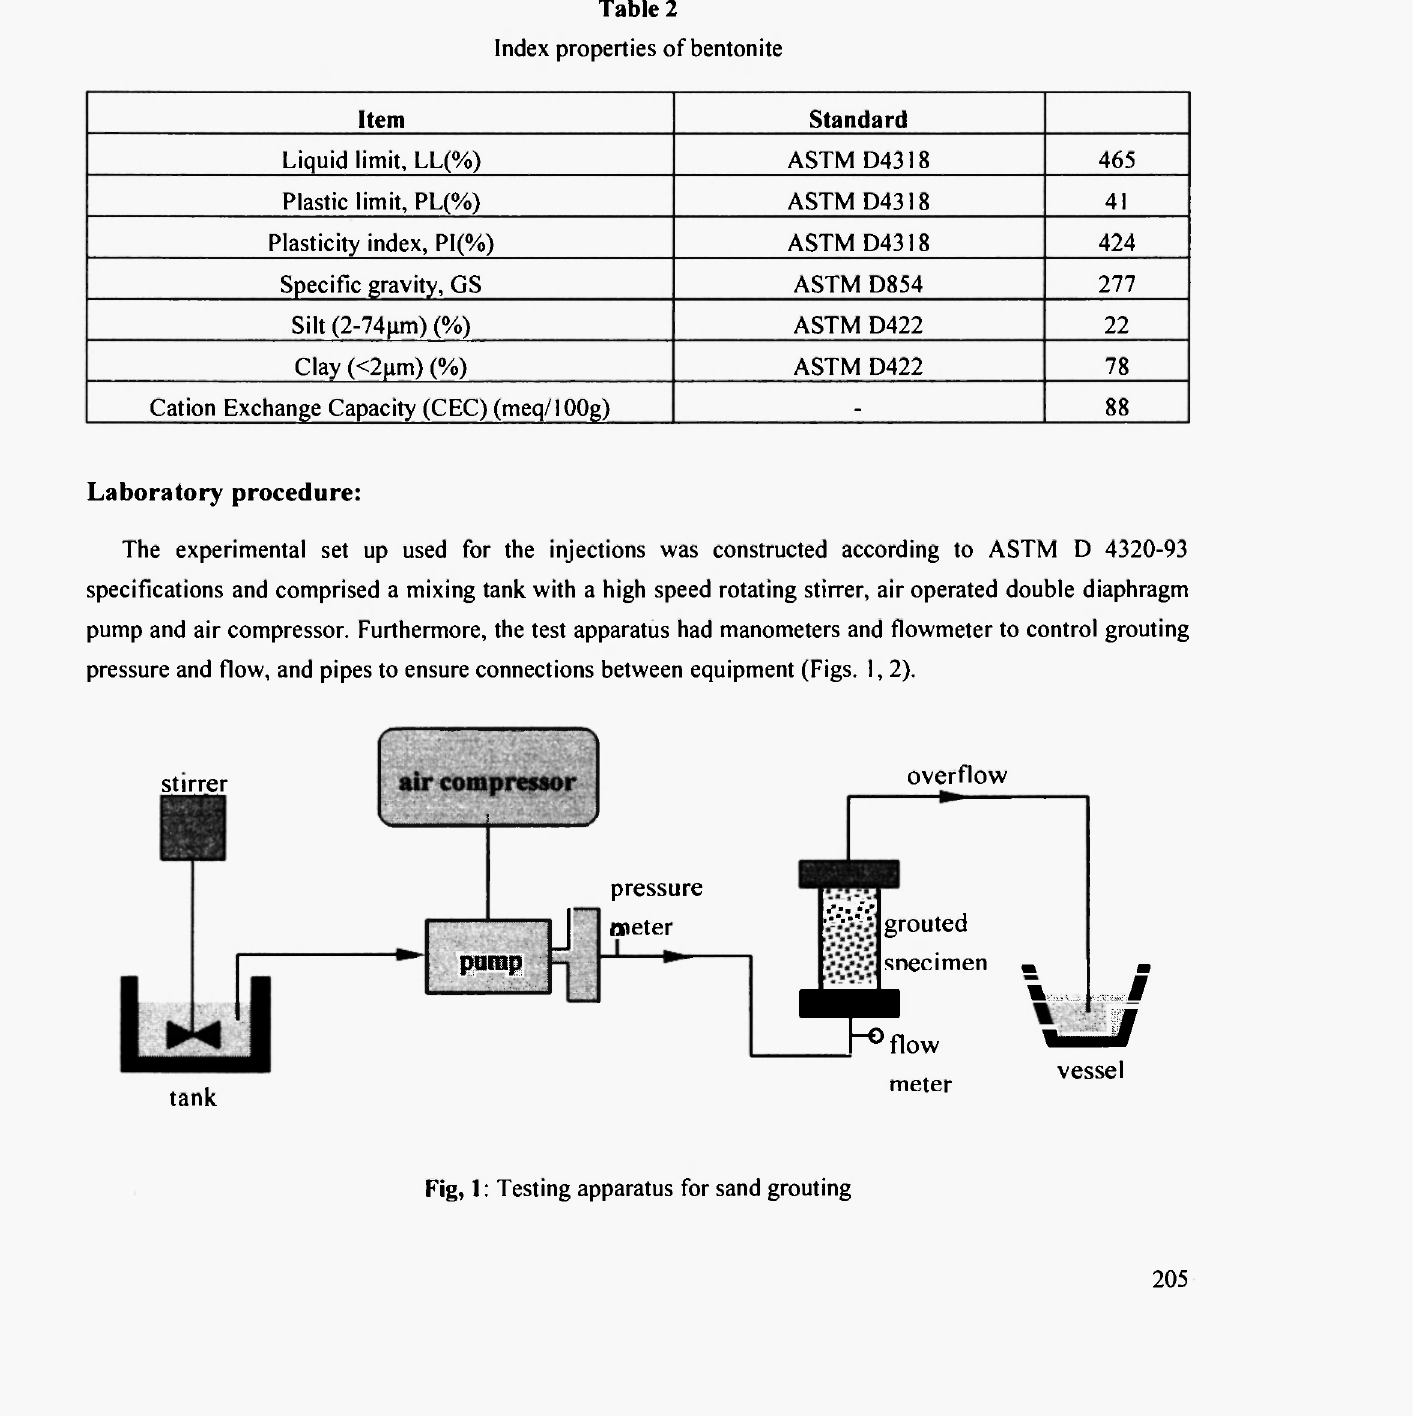
Fig, 1: Testing apparatus for sand